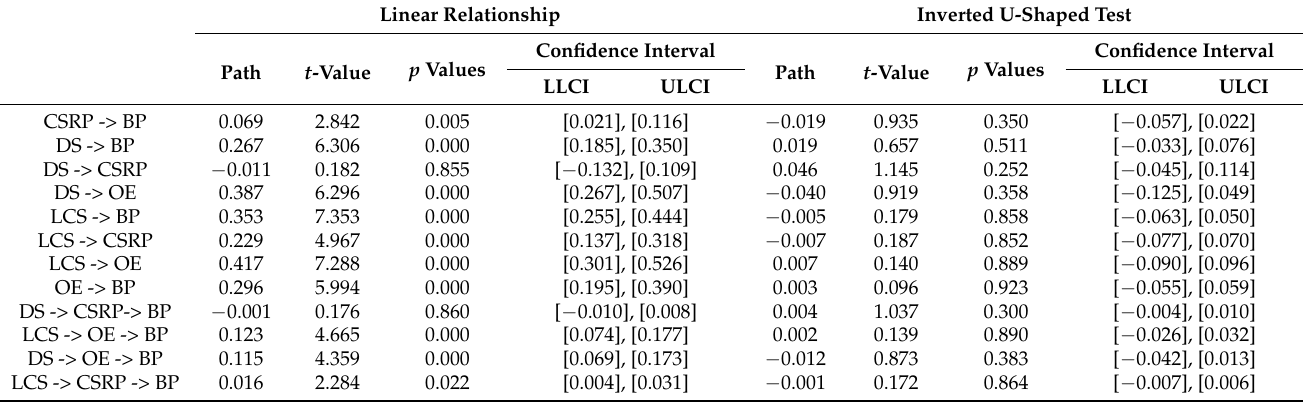
Table 3. Linear and curvilinear